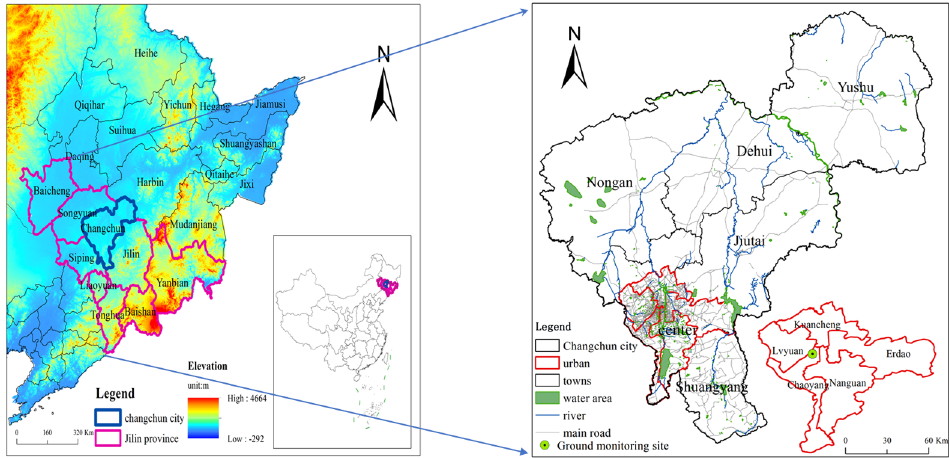
Figure 1. The location of the study region in northeastern China and its regional geography and elevation status. The bright purple area on the left indicates Jilin Province, Northeast China, and the dark blue indicates the administrative boundary of Changchun, which is the capital of Jilin Province and the subject of this study. The light red area on the right represents the urban center of the Changchun region, and the green circles are the ground monitoring sites in this study.